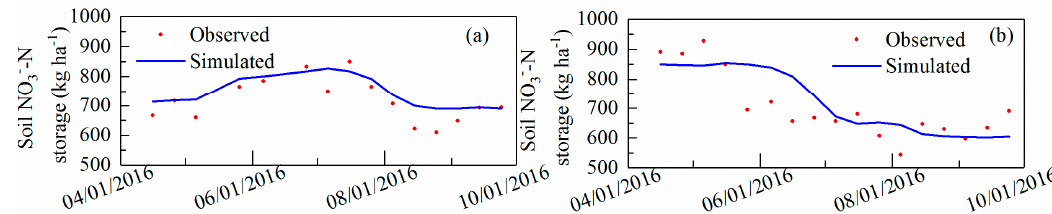
Figure 3. Comparisons of observed and simulated Soil NO 3 − -N storage for calibration ( a ) and validation ( b ) in the 0–180 cm soil profile.